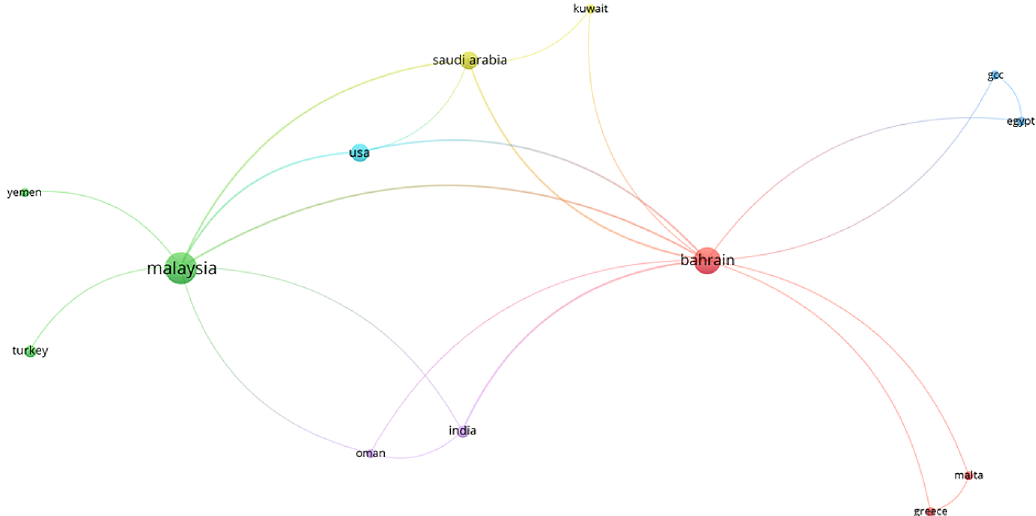
Figure 5. The collaboration network of countries.